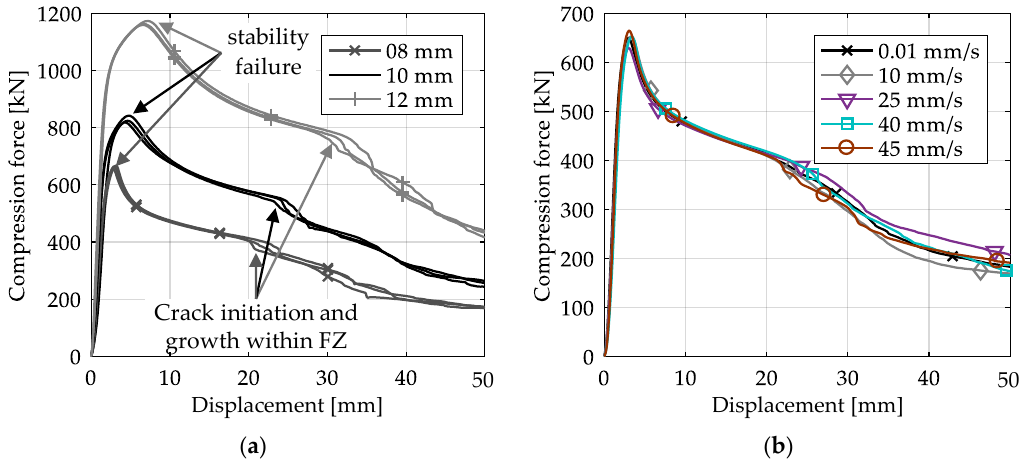
Figure 18. Force – displacement curves of axial compression tests with ( a ) various plate thicknesses and ( b ) various loading velocities for 8-mm plate thickness (averaged curves).